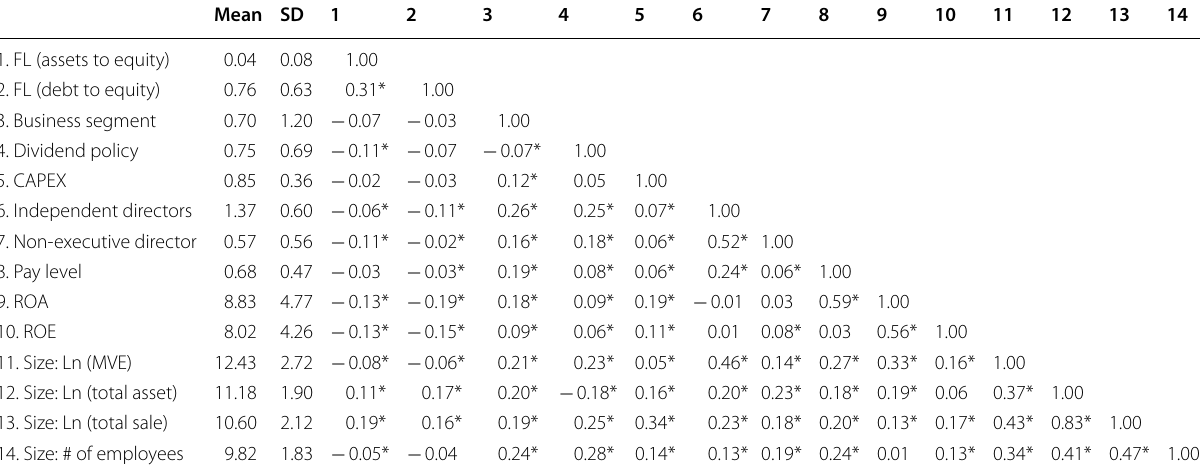
FL financial leverage, SD standard